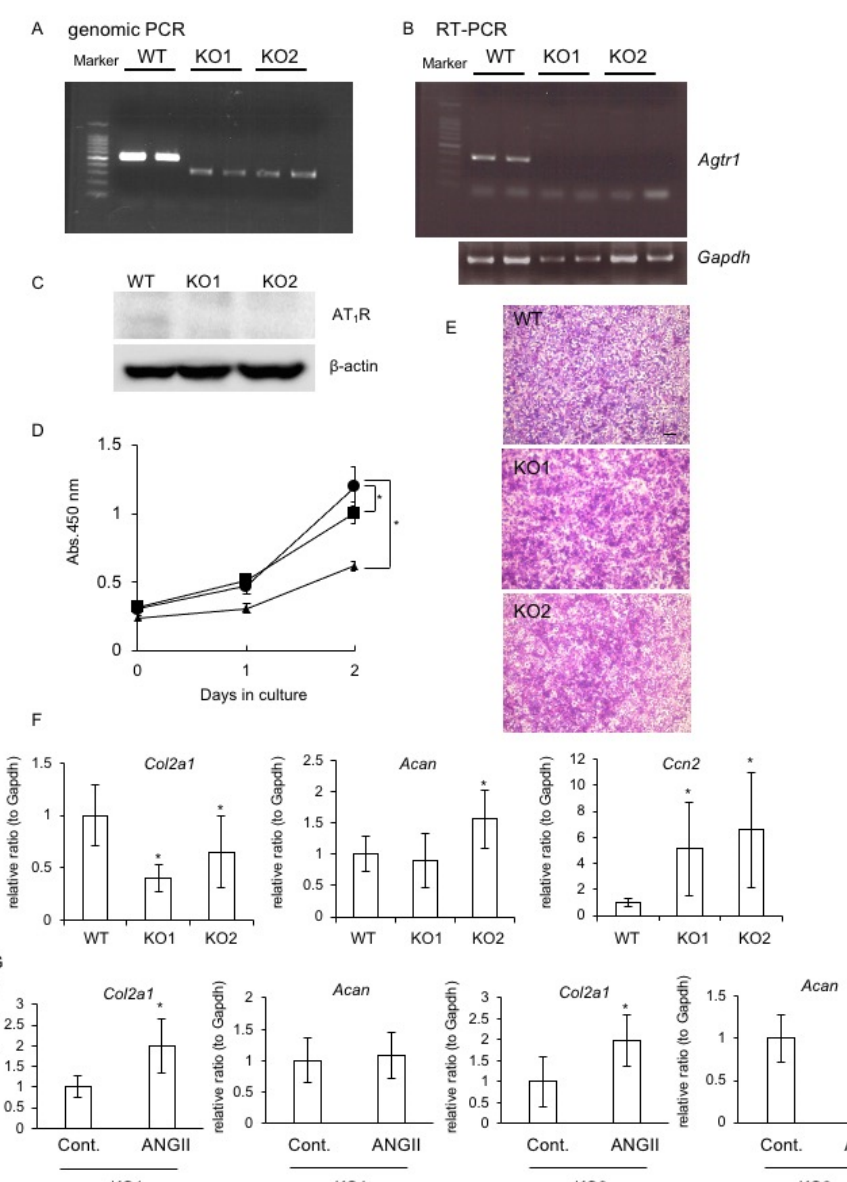
Figure 3. Generation of Agtr1a -deficient RCS cells. ( A ) Agarose gel electrophoresis shows PCR products of 526 base pairs (bp) from WT cells and 290 bp from KO1 and KO2 cells. The bands are shown in duplicate. ( B ) Agtr1a expression in WT, KO1, and KO2 cells at the mRNA level. The bands are shown in duplicate. ( C ) Western blot analysis of AT 1 R in WT, KO1, and KO2 cells. The band of AT 1 R was detected in WT cells but not in KO1 and KO2 cells. ( D ) Cell proliferation of WT (closed circle), KO1 (closed square), and KO2 cells (closed triangle) determined by using WST-8 on days 0, 1, and 2. The graph shows the mean and standard deviation of the results from 10 wells. ( E ) Toluidine blue staining of WT, KO1, and KO2 cells at confluence. Metachromasia was more pronounced in KO1 and KO2 cells than it was in WT cells. Scale bar = 100 µ m. ( F ) The gene expression of Col2a1 , Acan, and Ccn2 in WT, KO1, and KO2 cells by quantitative RT-PCR analysis. The amounts of these mRNAs were normalized to the amount of GAPDH mRNA. ( G ) Effect of ANG II on the gene expression of Col2a1 and Acan in KO1 and KO2 cells. KO1 and KO2 cells were treated with 200 nM ANG II for 24 h. The ordinates of the graphs indicate the relative ratio with respect to the control (control = 1.0). The data were analyzed by using the unpaired Student’s t -test to compare the data from 2 groups. The asterisk indicates a significant difference from the WT at * p < 0.05.